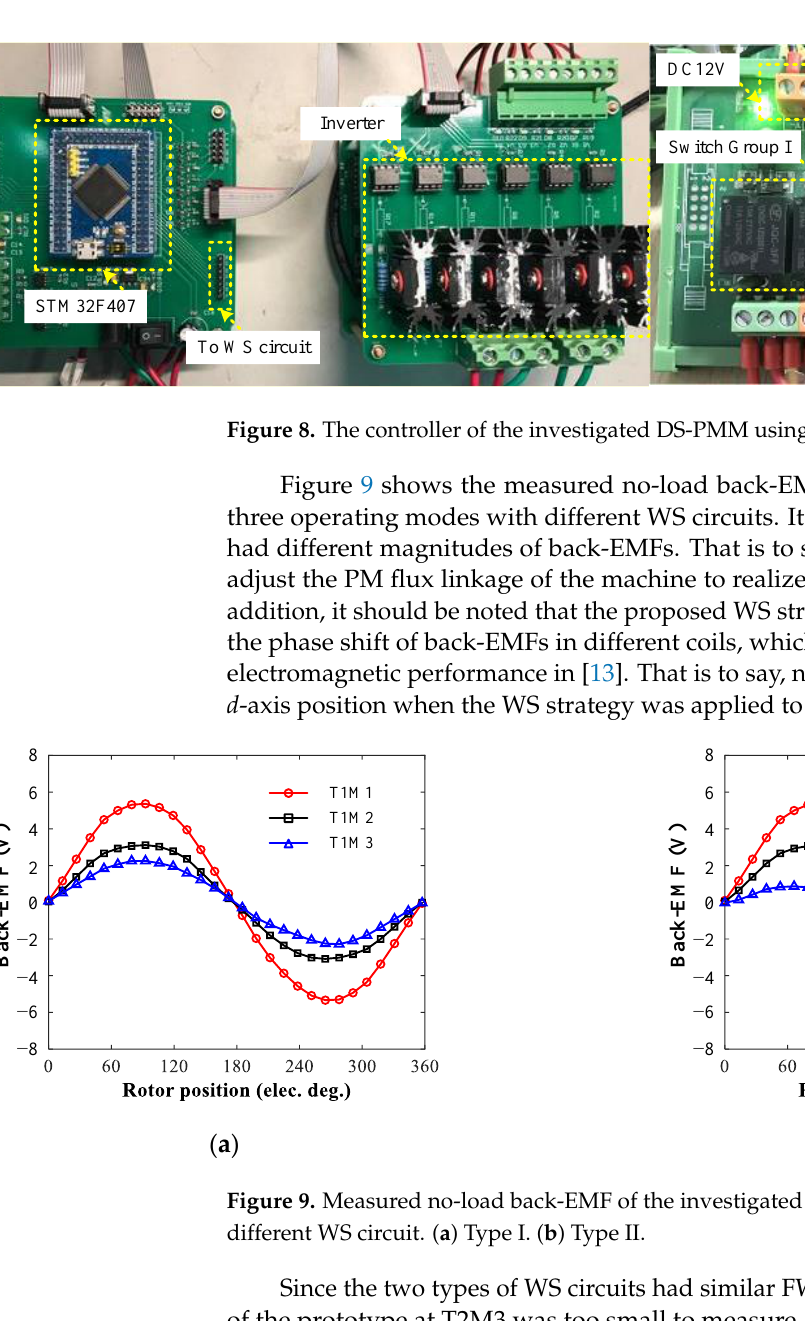
Figure 7. The test rig of the WS control strategy for the investigated DS-PMM.